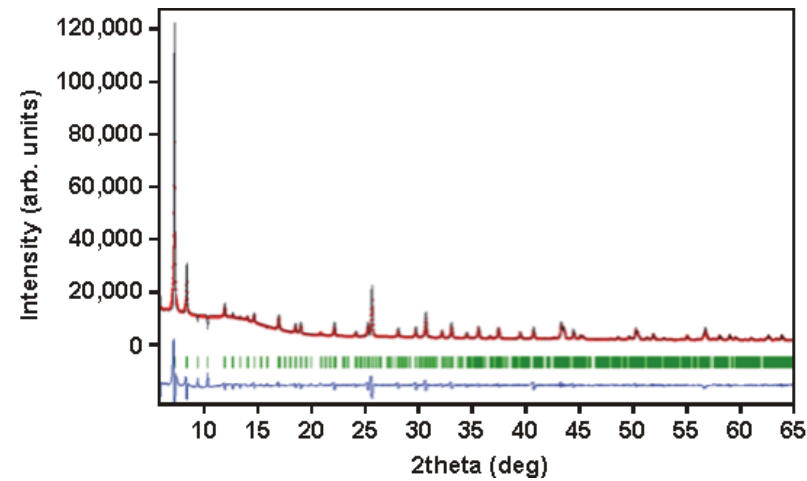
Figure 2. The diffraction pattern of synthesised material and the result of their refinement with tetragonal cell a=b=10.38 Å and c= 23.96 Å . The blue line represents the difference of the patterns.